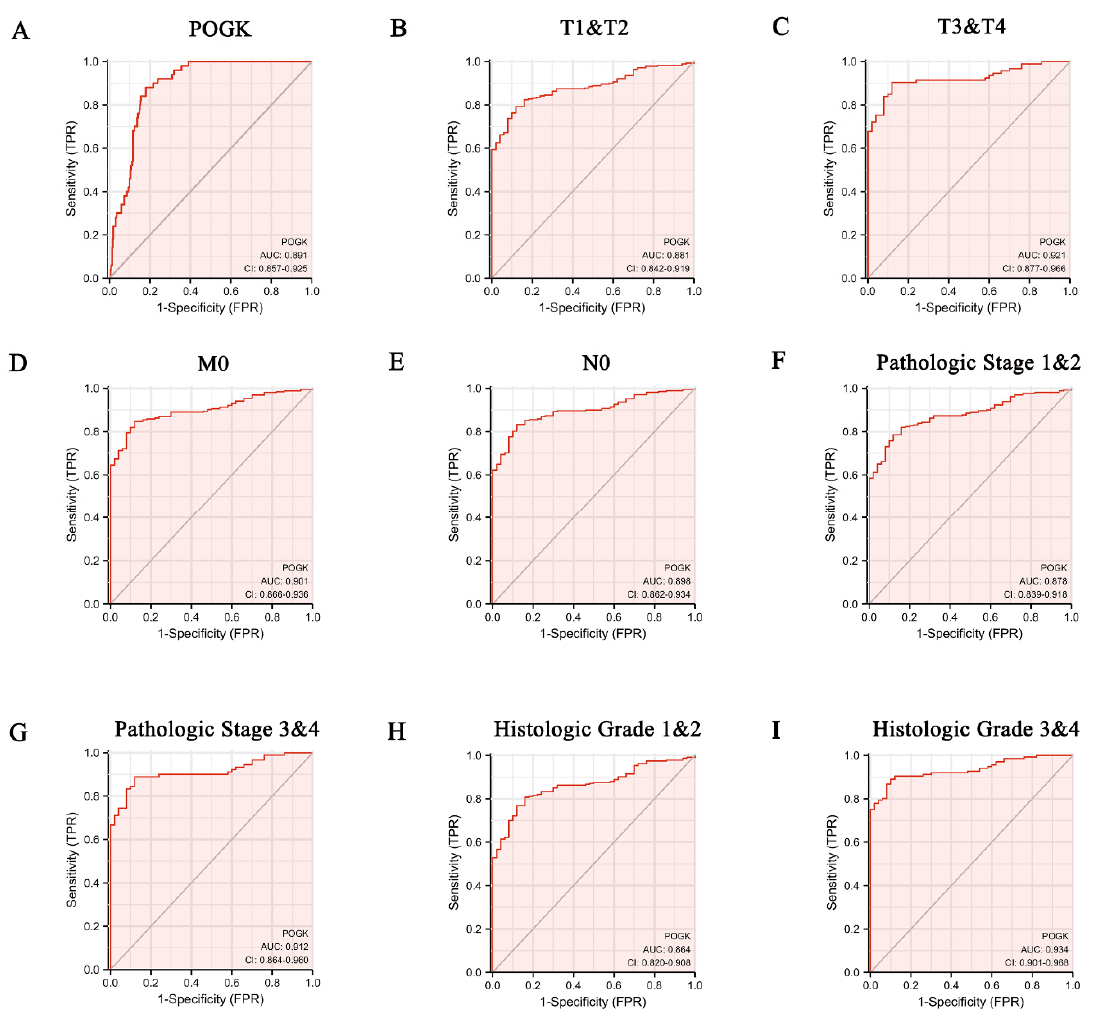
Figure 5. ROC curve for diagnostic value of POGK expression in patients with hepatocellular carcinoma. ( A ) in tumor tissue; ( B ) T1 and T2 stage; ( C ) T3 and T4 stage; ( D ) M0 stage; ( E ) N0 stage; ( F ) pathologic stage 1 and 2; ( G ) pathologic stage 3 and 4; ( H ) histologic grade 1 and 2; ( I ) histologic grade 3 and